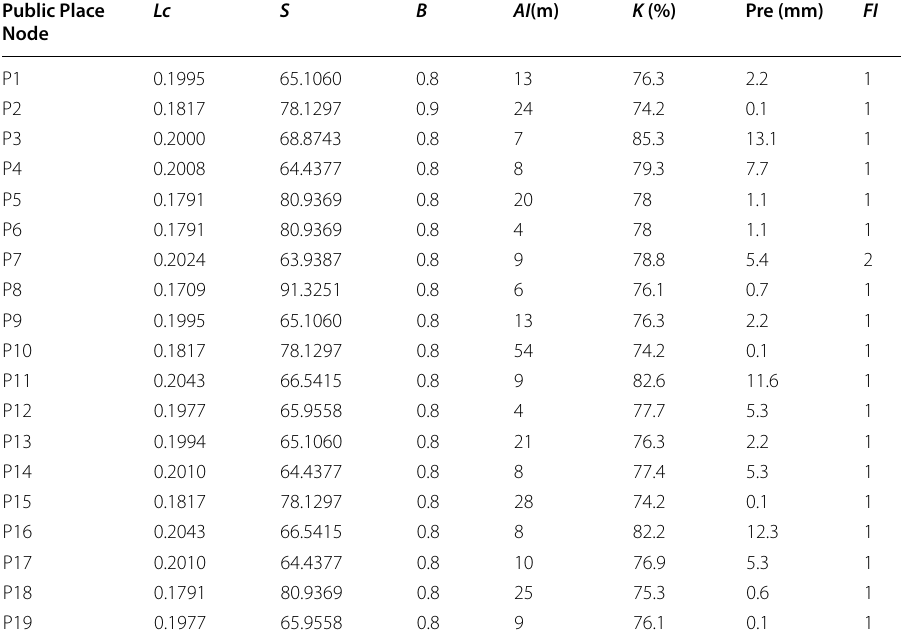
Table 1 Values of the seven parameters of BDC Network Public Place